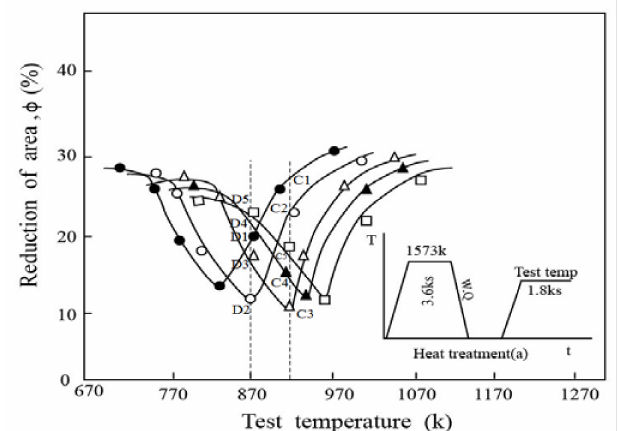
Figure 3. Variation in reduction of area with temperature and strain rate for an Fe-17Cr steel after heat treatment as shown in inset ( • : (cid:78) : . ε = 1.43 × 10 − 2 s − 1 , and (cid:3) : . ε = 1.43 × 10 − 1 s − 1 ). Reprinted with permission from ref.